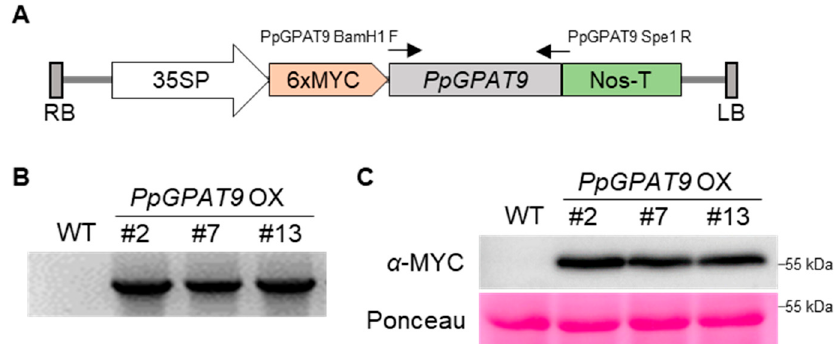
Figure 4. Generation of transgenic A. thaliana plants ectopically expressing PpGPAT9 under the control of the CaMV 35S promoter. ( A ) Schematic diagram of the 35SP:6xMYC-PpGPAT9 construct. 35SP, Cauliflower mosaic virus 35S promoter; LB, left border; Nos-T, nopaline synthase terminator; RB, right border. The arrows indicate forward and reverse primer sites. ( B ) Genomic DNA (gDNA) PCR. The gDNA was isolated from the wild type (WT) and 3-week-old transgenic leaves ectopically expressing PpGPAT9 (#2, #7, and #13) of the T 1 generation. ( C ) Immunoblot analysis. Total proteins were extracted from 10-day-old seedlings of WT and transgenic lines ectopically expressing PpGPAT9 of the T 2 generation. Anti-myc antibodies were used to detect chemiluminescence (upper image) after 1 min of exposure. Protein quality and quantity were confirmed using Ponceau S (bottom image).